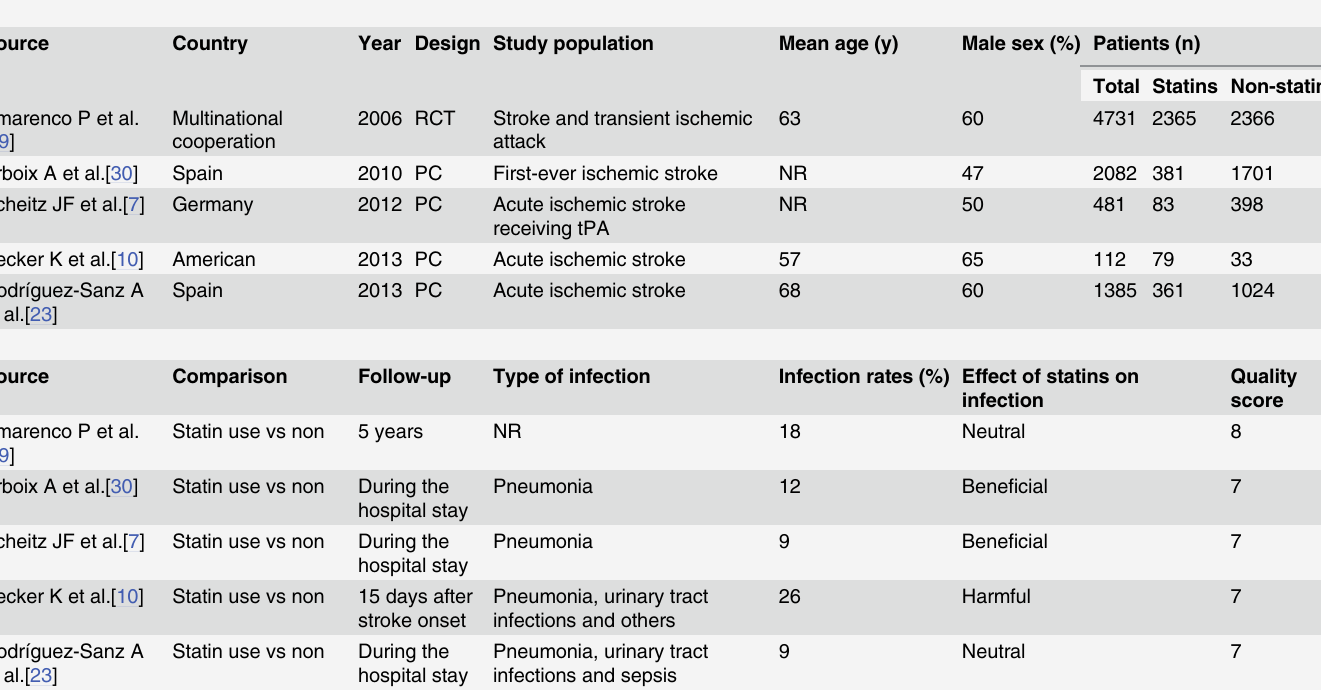
Table 1. Characteristics of the included studies. RCT, randomized controlled trial; PC, prospective cohort study; tPA, tissue plasminogen activator; NR, not